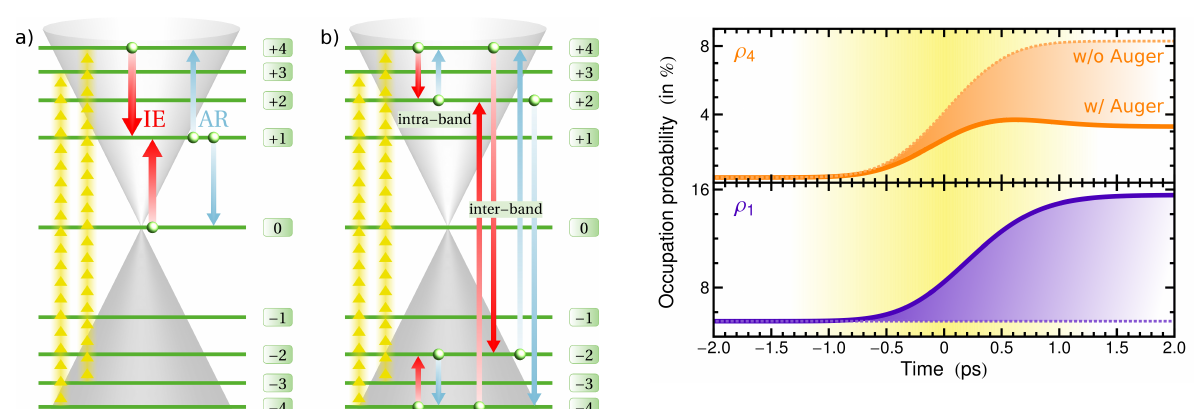
Figure 17: Importance of Auger scattering. Temporal evolution of the occupations ρ +4 and ρ +1 during an optical excitation as sketched in Fig. 16a. The dashed lines represent the dynamics in the absence of Auger scattering. The yellow region illustrates the = 1ps ). The Figure is taken from width of the pump pulse ( σ exp FWHM Ref. [73] Copyright (2014) by Nature Publishing